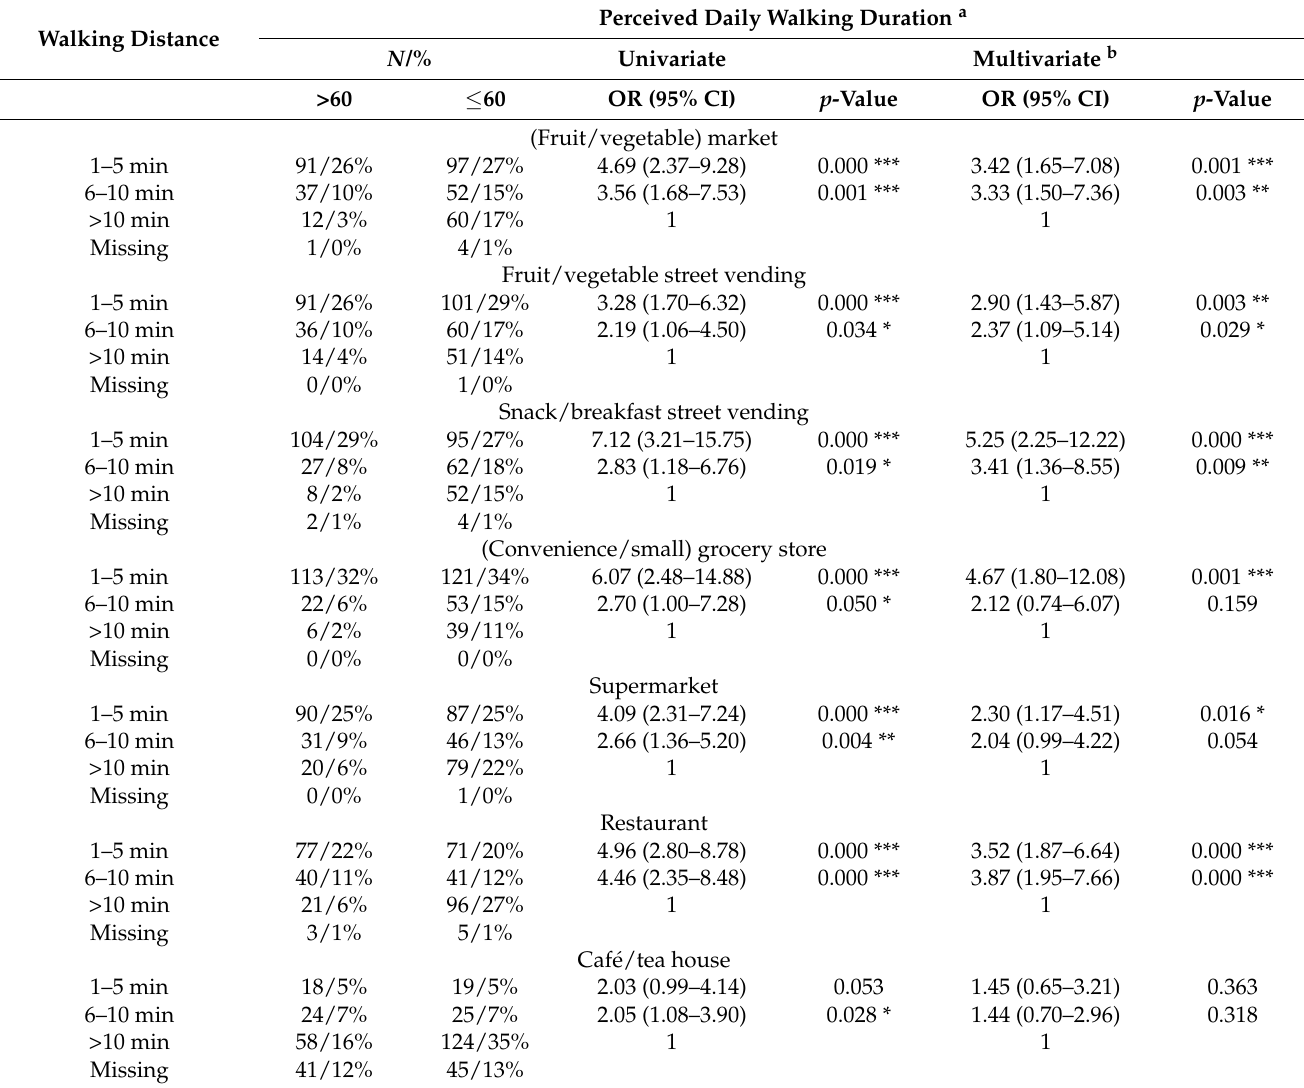
Table 3. Logistic regression analysis for the associations between residential food environment variables and perceived daily walking